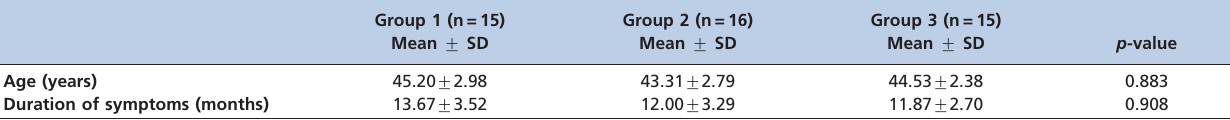
Table 1 - Demographic characteristics of the patients.